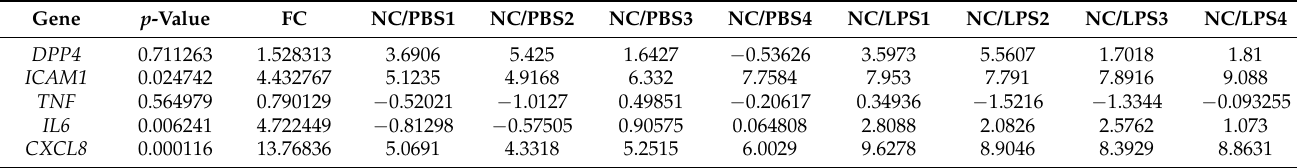
Table 4. Gene expression levels of ARDS-relevant factors after LPS (NC/PBS vs. NC/LPS). Normalized gene signals of each sample are shown in the table.